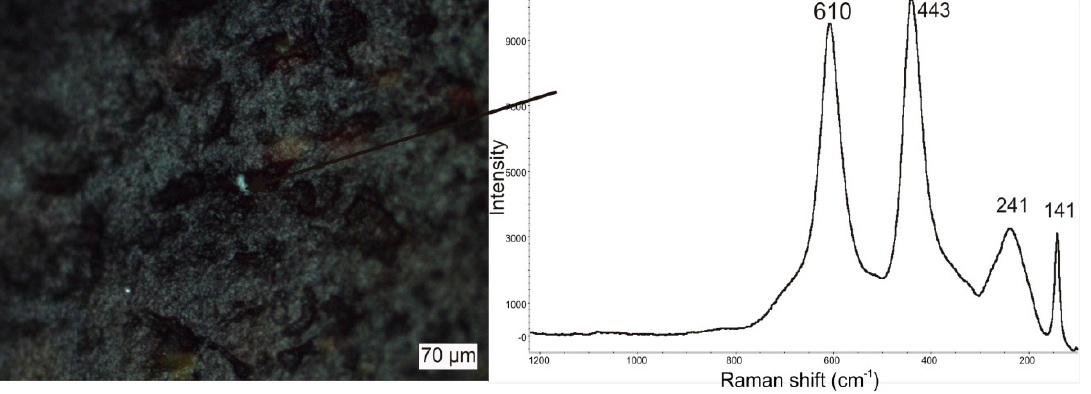
Figure 8. Microphoto of rutile in agate with its Raman spectrum. Table 1. Raman bands (cm − 1 ) observed in spectra shown in Figures 6–8.